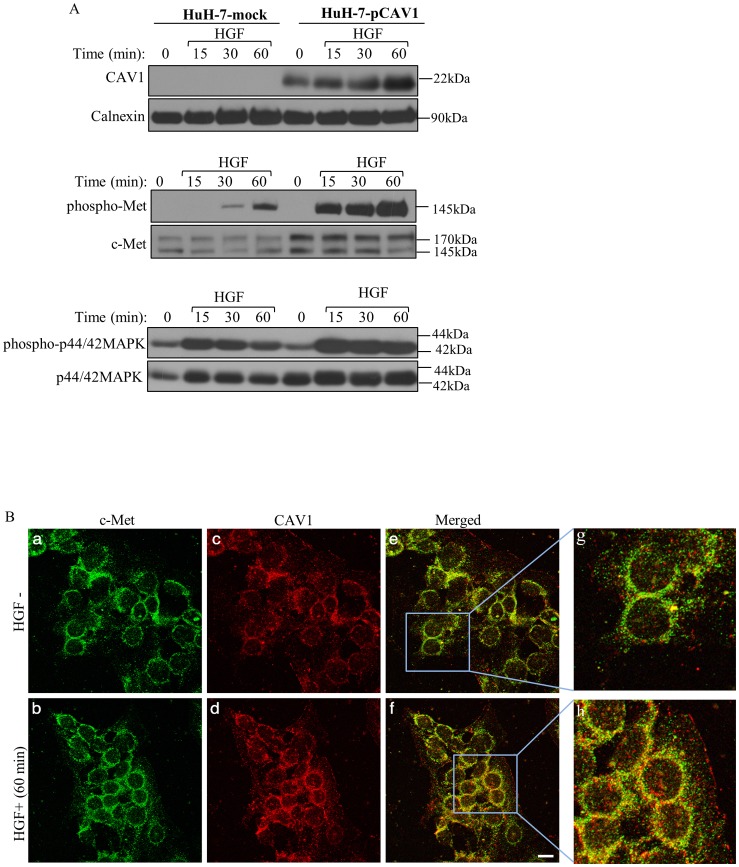
Ectopic expression of CAV1 enhanced HGF-mediated c-Met activation.
A. Huh-7-mock and HuH-7-pCAV1 cells were starved for overnight prior to stimulation with HGF for 15, 30 and 60 min. Expression of phosphorylated and total c-Met and MAPK were examined by WB. Overexpression of CAV1 was also verified by WB. Calnexin is shown as a loading control. B. After 60 min treatment with HuH-7-mock, cells stably expressing CAV1 were fixed and stained for c-Met (green) (a, b) and CAV1 (red) (c, d), colocalization signal (yellow) (e, f). Representative fluorescence micrographs were obtained by CM. Higher magnification images were presented to reveal the incidence of colocalization (g, h). Bar: 200 µm.